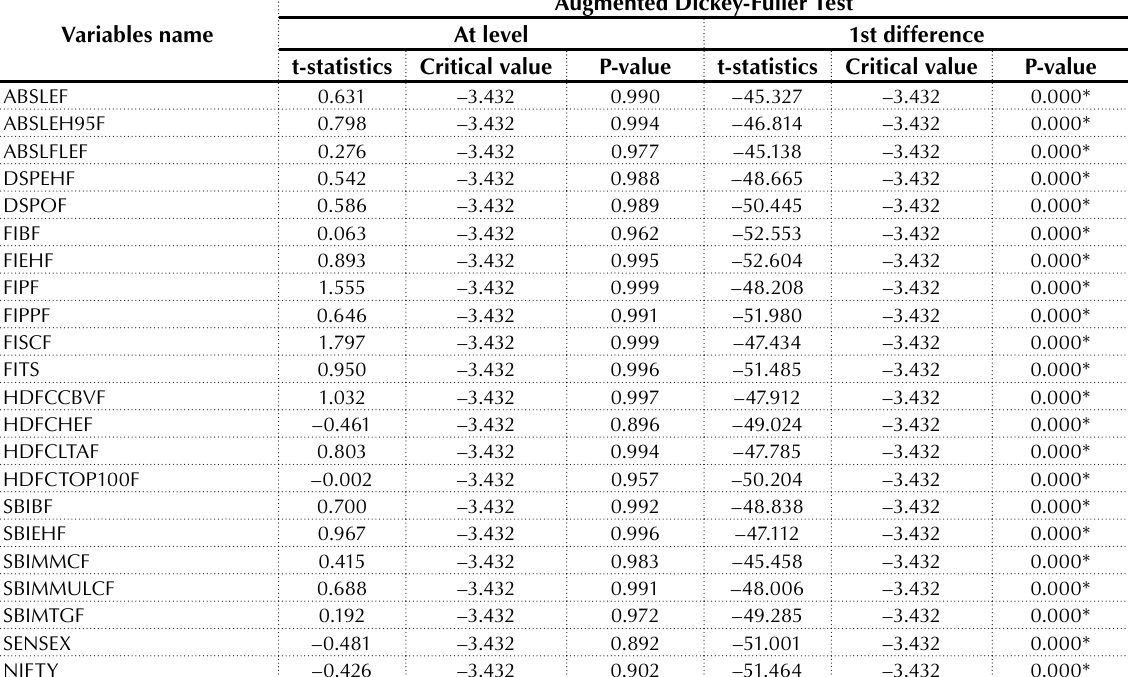
Table 3. Stationary test